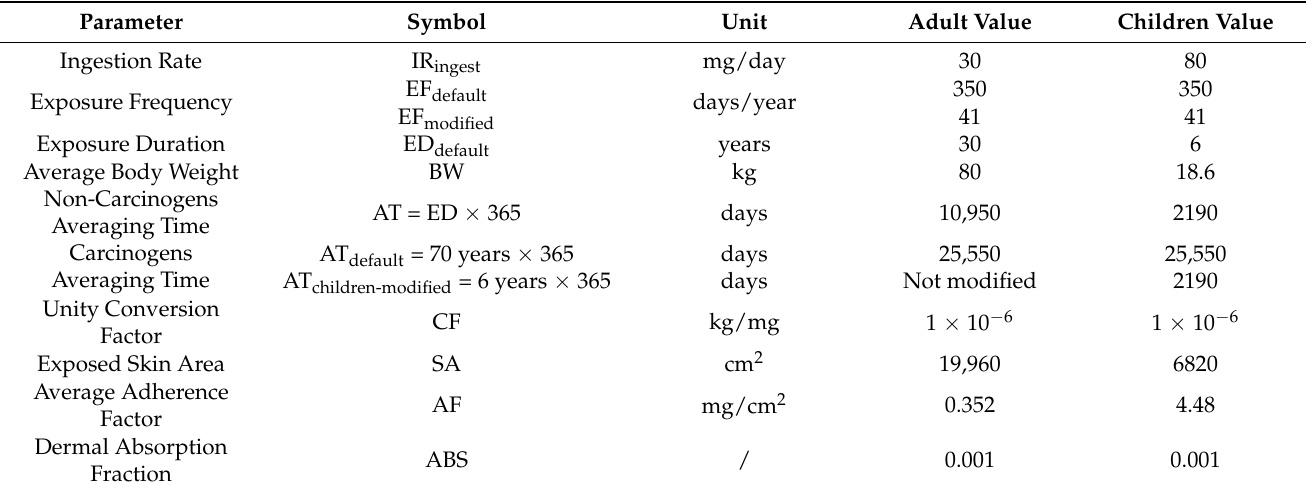
Table 2. Parameter values used to compute average daily dose by heavy metal ingestion and dermal contact [20–25].